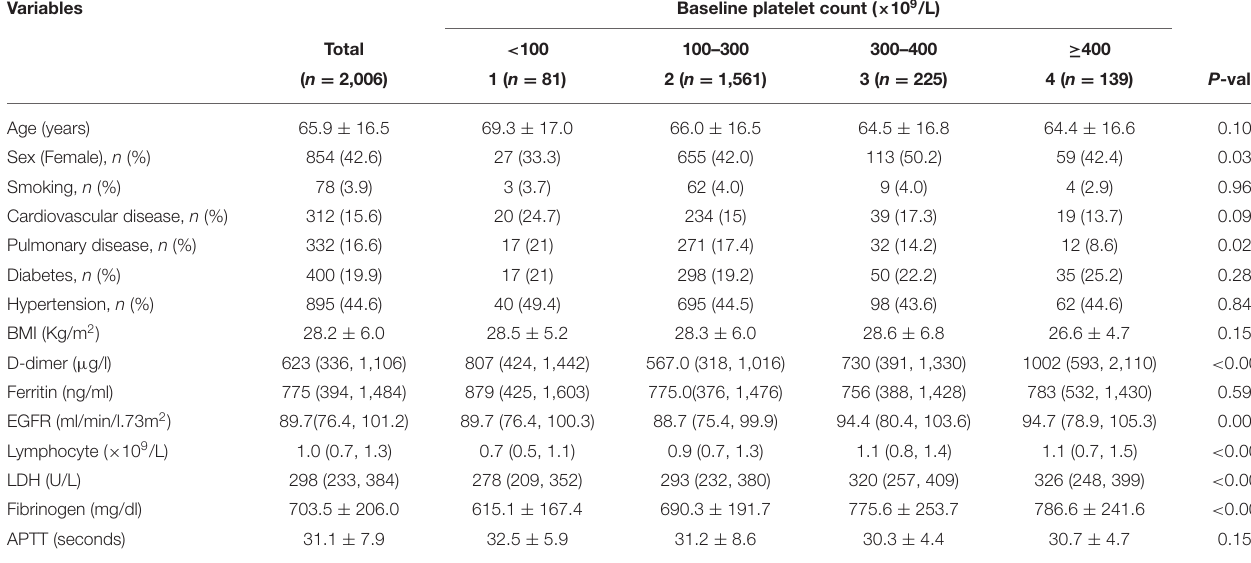
TABLE 2 | Baseline characteristics of platelet count analysis.